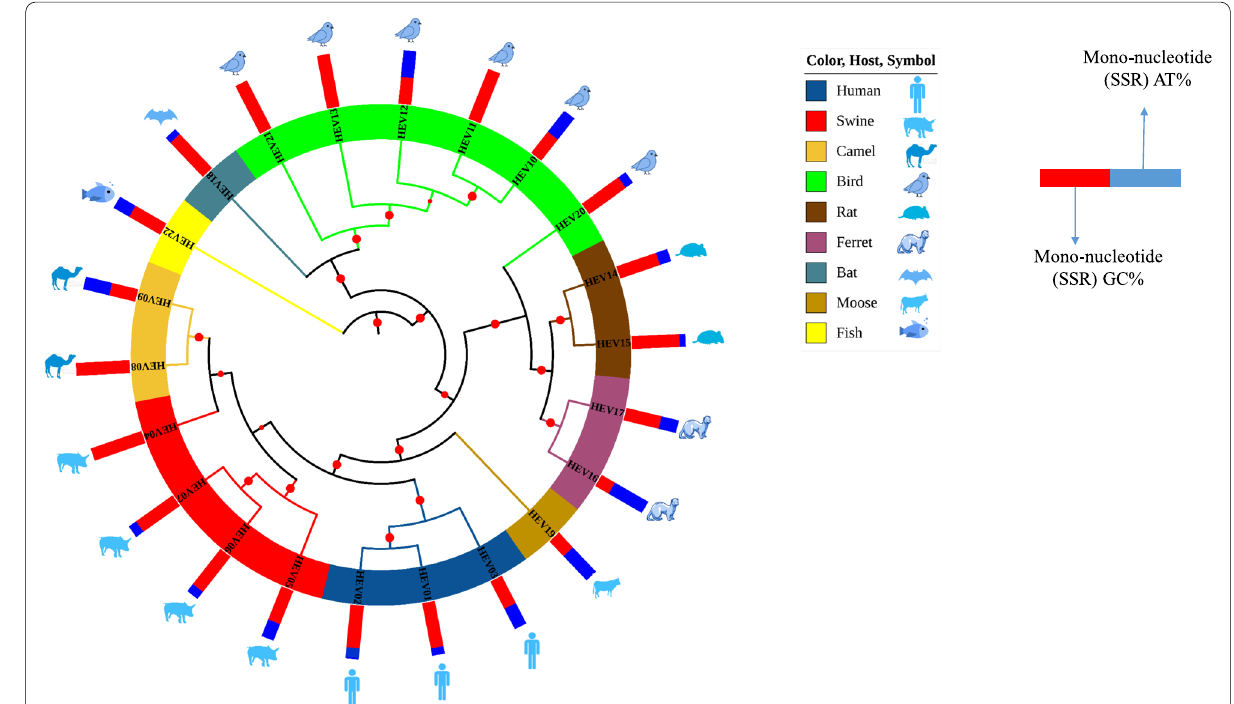
Fig. 6 Phylogenetic analysis of the HEV genomes and mono-nucleotide SSR